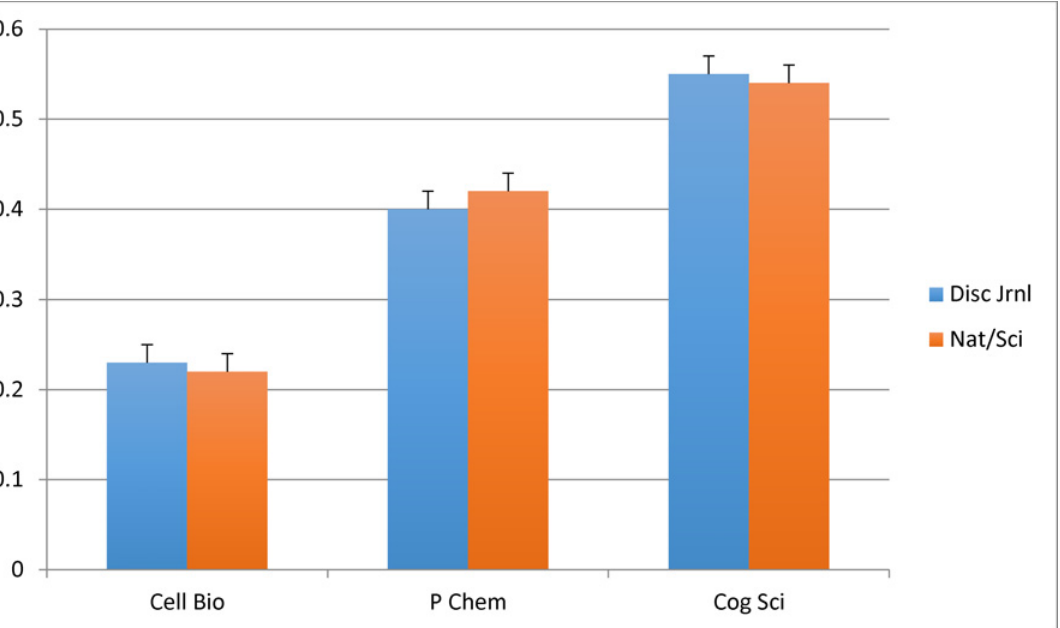
Fig 1. Mean Integration Scores of Articles Appearing in Disciplinary Journals Compared to those in Nature/Science , by Field. Cell Bio = Cell Biology, P Chem = Physical Chemistry, Cog Sci = Cognitive Science, Disc Jrnl = Disciplinary journal, Sci/Nat = Science and Nature .